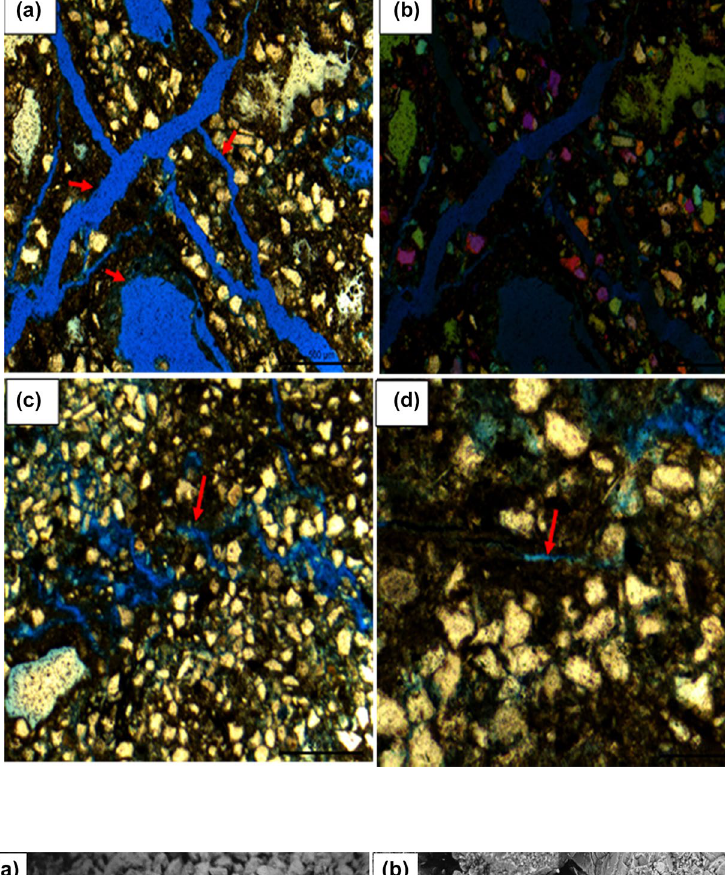
Fig. 13 SEM images of rep- resentative photomicrographs of massive very fine grained sandstone (MVFGS) showing different pore types: ( a ) grain shapes, poorly sorted, ( b ) fine- grained and carbonate fragment clogging intergranular pore space and pore throat, ( c ) grains in float and point contact pack- ing pores filled by fine grained matrix, ( d ) fine-grained matrix- fracture pore indicated by